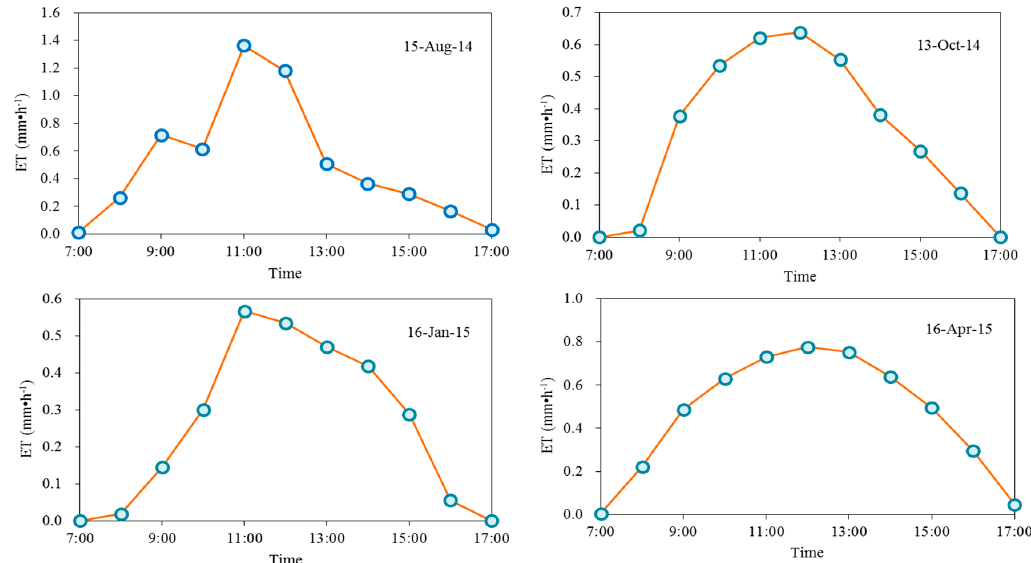
Figure 4. Diurnal variations of lawn ET on typical sunny days in the four seasons in Shenzhen. 15 August 2014, 13 October 2014, 16 January 2015, and 16 April 2015 represent summer, fall, winter, and spring, respectively.